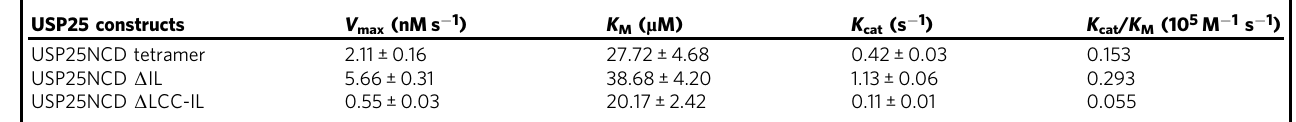
Table 2 Table of kinetic constant values for the USP25 oligomers USP25